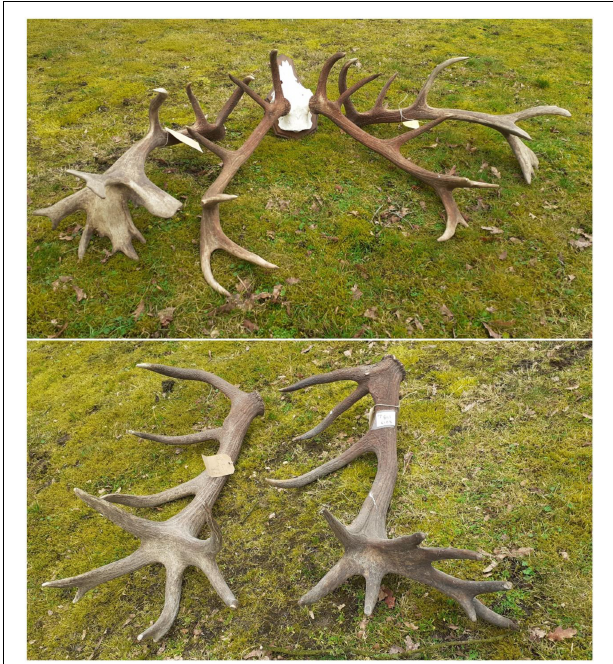
FIGURE 1 | Difference in the shape of red deer antlers of relic and estate populations of Netherlands. Above: Antlers characteristic for deer of the allochthonous estate Hoge Veluwe (outside) and the autochthonous relic population. The antlers are from deer that are approximately seven years old. The antlers differ, inter alia, in the shape of the crown, which is a fork in the relic population, but tends to form palms in the estate. Below: Antlers collected in the estate Hoge Veluwe in 1985 (left) and 2013 (estimated age of the deer: both eight years). The characteristic shape of tines and palms is retained over